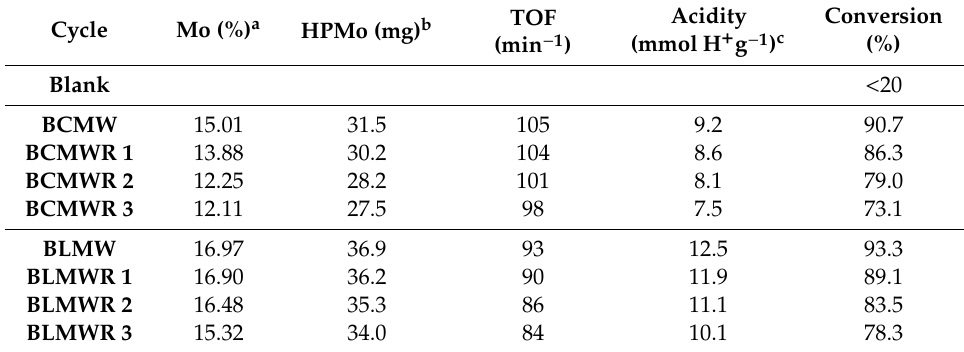
Table 5. Reuses of the catalysts under optimized reaction conditions.